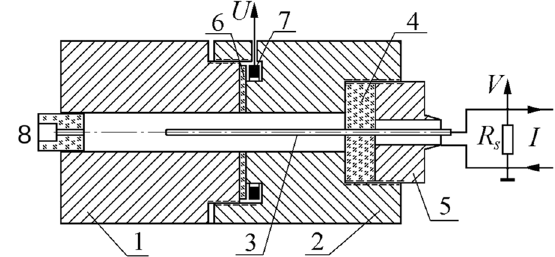
Figure 4. Experimental cell and feeding circuit.